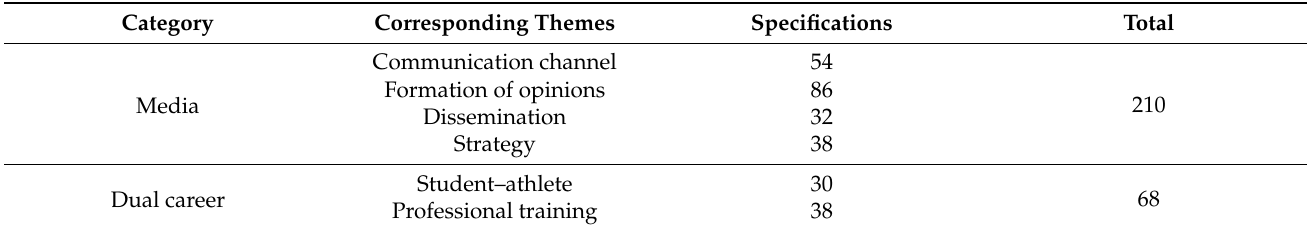
Table 3. Total number of specifications for “mass media” and “dual career.”